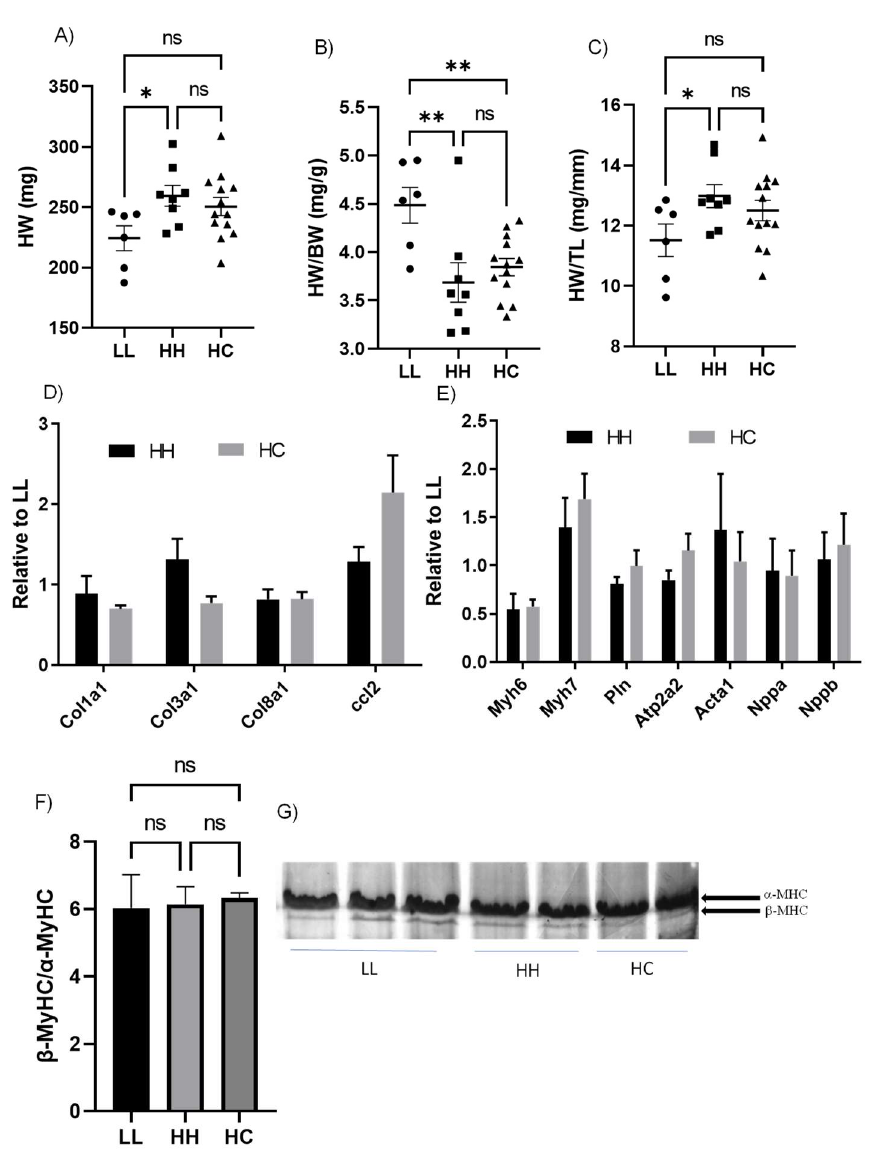
Figure 3. Cardiac adaptation associated with diets. ( A ) Absolute HW; ( B ) Relative HW normalized to BW; ( C ) HW normalized by TL; ( A – C ) n = 6 in LL; n = 8 in HH; and n = 8–13 in HC; ( D ) genes regulating extracellular matrix; ( E ) Genes associated with pathological cardiac hypertrophy; ( D , E ) n = 4–8 samples/group and fold changes relative to LL are shown. mRNA levels were normalized to B2M; ( F ) Bar graph represents the β-MyHC to α-MyHC ratio. n = 4–5/group with five technical replicates per animal; and ( G ) Representative gels showing myosin heavy chain (MyHC) isoforms in LV homogenates from LL, HH, and HC; HW, heart weight; BW, body weight; TL, tibial length; Col1a1 , collagen type 1 alpha chain; Col3a1 , collagen type III alpha 1 chain; Col8a1 , collagen type VIII alpha 1 chain; Ccl2 , C-C motif chemokine ligand 2; MyH , myosin heavy chain; Pln , phospholamban; Atp2a2 , cardiac sarcoplasmic reticulum Ca2+ ATPase 2a; Acta1 , alpha-skeletal muscle actin; Nppa , atrial natriuretic peptide; Nppb , brain natriuretic peptide; LL, offspring born from maternal LFLS and postnatal LFLS indicated by closed circles (●); HH, maternal HFHS and postnatal HFHS indi- cated by closed squares ( ■ ); HC, maternal HFHS weaned onto a standard laboratory chow diet indicated by a closed triangle ( ▲ ). Values are presented as mean ± SEM. Statistical significance is calculated by one-way ANOVA with post hoc Fisher’s LSD comparisons. * p < 0.05; ** p < 0.01; ns, not significant. Echocardiographic assessment of the left ventricle (LV) revealed that the LV structure and systolic function were similar among groups, except for LV diameter (Table 2). The